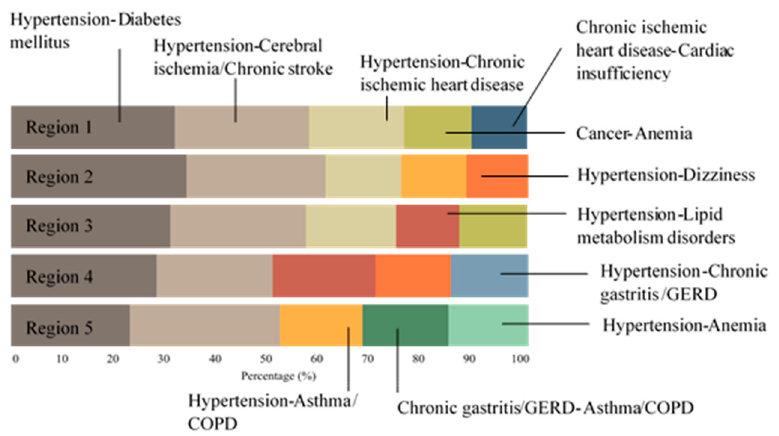
Figure 2. Proportions of the most common disease dyads according to region.